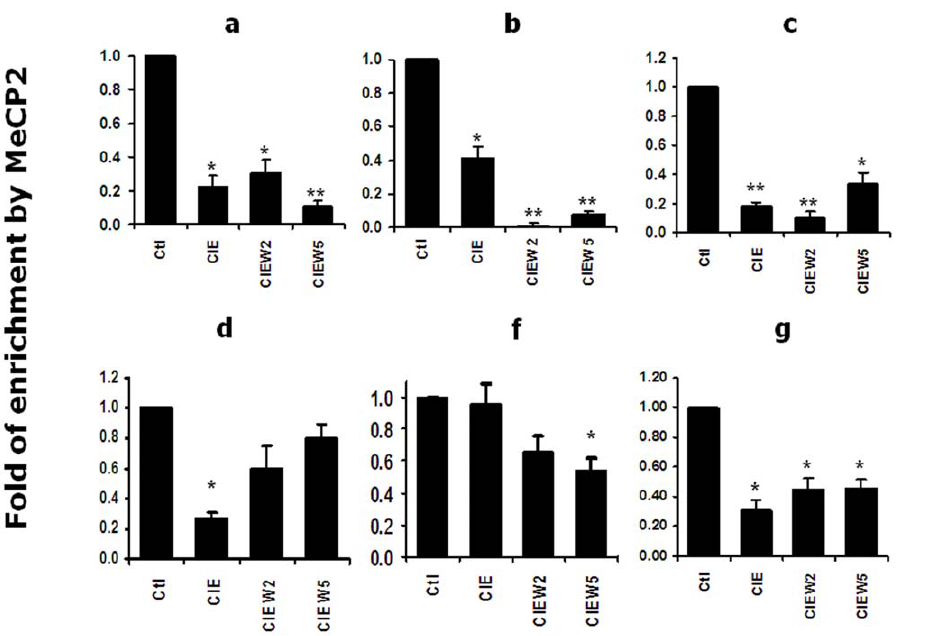
Figure 6. CIE reduced the association of MeCP2 with chromatin in specific regions. The chromatin fragments were prepared by cross- linking using 1% formaldehyde and precipitating with antibody specific to MeCP2. The qChIP PCR was performed to selectively amplify the region a, b, c, d, f and g. Each of the individual graphs represents the CIE-induced changes in region a to g (see Figure1). *, p , 0.05; **, p , 0.01 compared to the control.